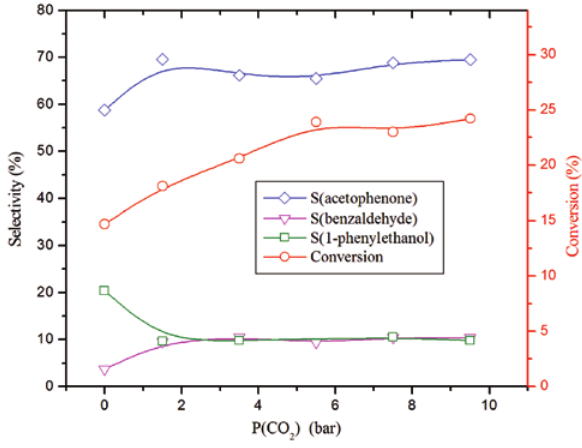
pressure on conversion and PO selectivity. 2 O /ethylbenzene) volume ratio = 2.5; tr = 7 h; 2 2